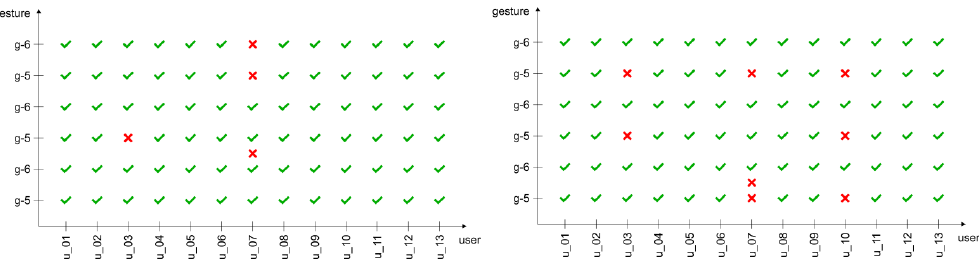
Figure 9. Detailed results for the S-5 scenario.